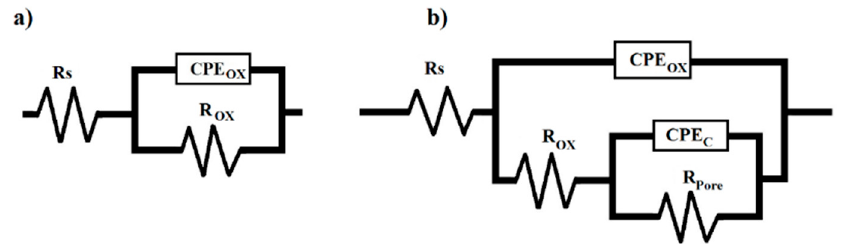
Figure 7. Scheme of the electrical equivalent circuits corresponding to EIS plots of: ( a ) NiW chloride and ( b ) NiW sulfate coatings.